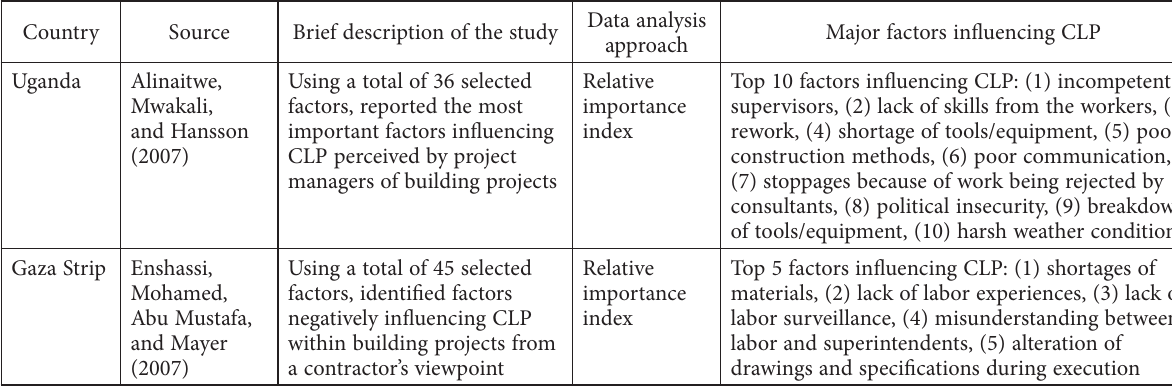
labor surveillance, (4) misunderstanding between labor and superintendents, (5) alteration of drawings and specifications